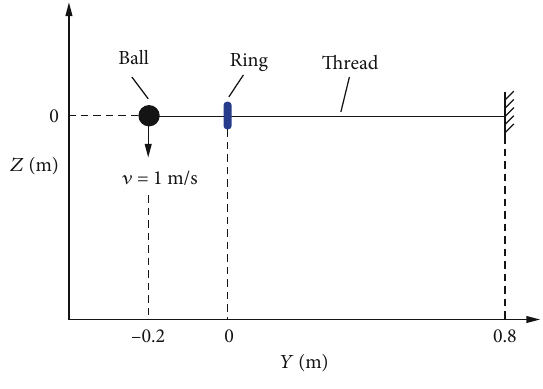
Figure 6: Initial state of the simulation. Table 1: Simulation